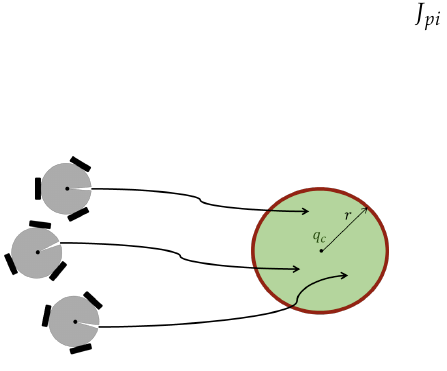
Figure 8. Geometric permissible